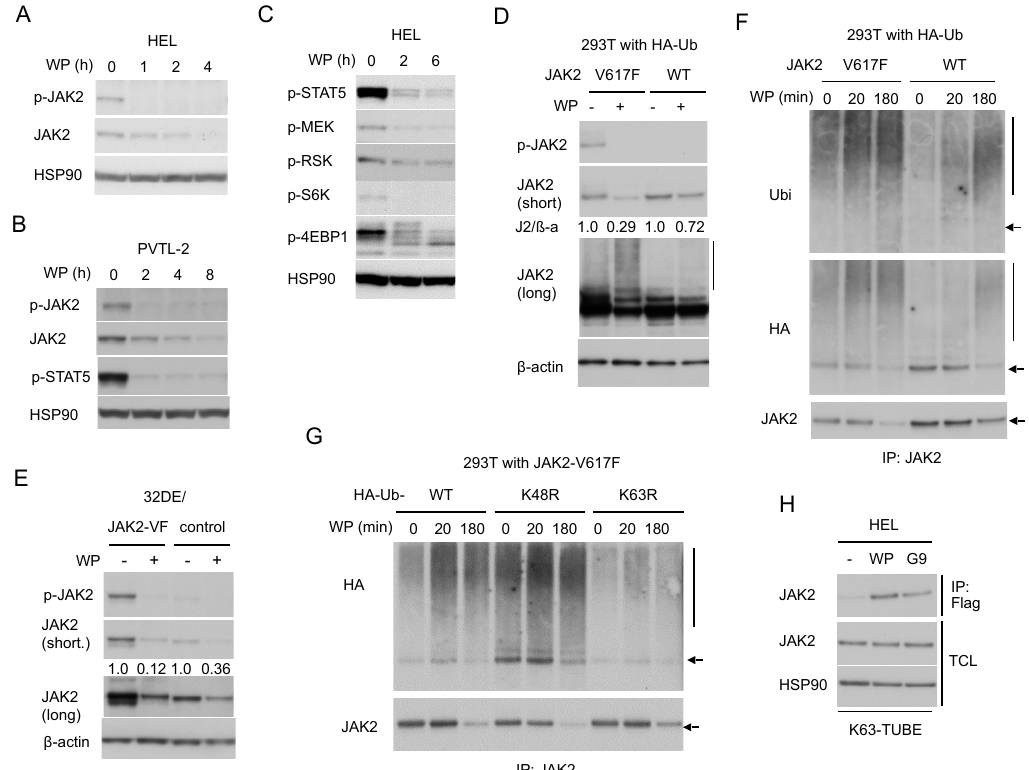
Figure 2. WP1130 enhances K63-linked polyubiquitination and preferentially downregulates the phosphorylated form of JAK2-V617F to inhibit downstream signaling. ( A , B , C ) HEL ( A , C ) or PVTL-2 ( B ) were treated with 5 µ M WP1130 (WP) for indicated times. Cells were lysed and subjected to immunoblot analysis with antibodies against indicated proteins. HSP90 was used for a loading control. ( D ) 293T cells transfected with plasmids coding for either JAK2-V617F (V617F) or wild-type JAK2 (WT) and HA-tagged ubiquitin were treated for 3 h with or without 5 µ M WP1130, as indicated, and analyzed. β -actin was used for a loading control. Short and long exposure results are shown where indicated. Relative expression levels of JAK2 as compared with those in untreated cells analyzed by densitometry and normalized by that of ß-actin (J2 / β -a) are indicated. The vertical line indicates the smeary pattern characteristic of polyubiquitination. ( E ) 32DE / JAK2-V617F cells or vector control cells cultured with Epo were treated with or without 5 µ M WP1130 for 2 h, as indicated, and analyzed. ( F ) 293T cells transduced with HA-tagged ubiquitin along with either JAK2-V617F or wild-type JAK2 were treated for indicated times with 5 µ M WP1130 and lysed. Immunoprecipitates (IP) obtained with anti-JAK2 were analyzed. The arrow indicates the position corresponding to JAK2. ( G ) 293T cells transduced with JAK2-V617F along with HA-tagged ubiquitin (WT) or its K48R or K63R mutant were treated with 5 µ M WP1130 for indicated times and analyzed. ( H ) HEL cells were left untreated as control or treated for 30 min with 5 µ M WP1130 or 3 µ M G9 as indicated. K63-polyubiquitinated proteins were isolated by immunoprecipitation with anti-Flag after incubation of cell lysates with FLAG-K63-TUBE (K63-TUBE). Immunoprecipitates, as well as total cell lysates (TCL), were